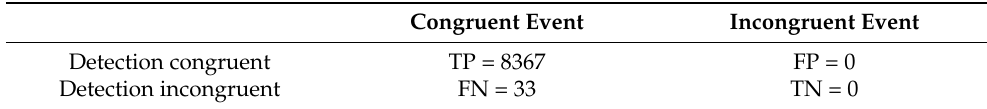
Table 5. Contingency table that assists with the detection of congruences in the Landsat 8 scene of the Doce River basin acquired in 2013 and consisting of 8400 tiles (TP—true positive, FP—false positive, FN—false negative, TN—true negative).